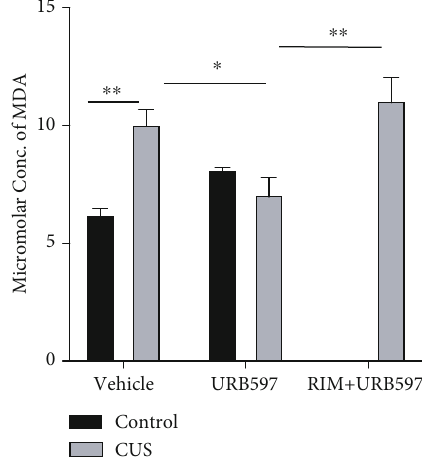
Figure 3: TBARS assay results. Columns represent mean of MDA concentration ± SEM , n = 6 /group; ∗ p ≤ 0 : 05 ; ∗∗ p ≤ 0 : 01 . Two-way ANOVA post hoc Holm-Sidak ’